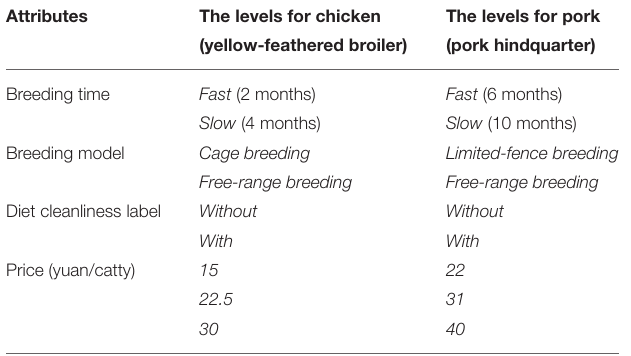
TABLE 2 | Consumption options of livestock and poultry products.